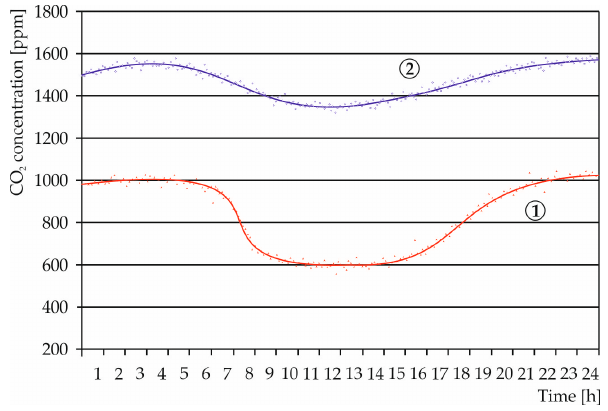
Figure 2. Comparison of the variability in the concentration of carbon dioxide in apartment 1, with mechanical ventilation, apartment 2, with natural ventilation.